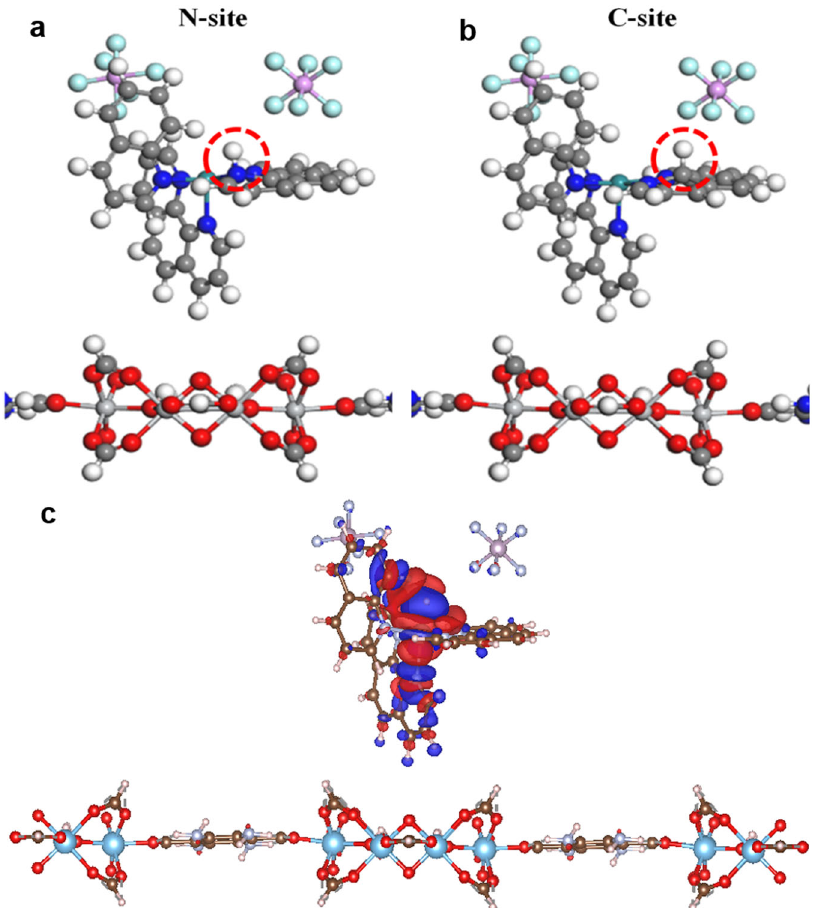
Fig. 6 DFT studies and their consecutive models. DFT-Optimized ball and stick structures of hydrogen adsorption on a N-site, b C-site of polymer. We have only shown the structure around the polymer, c difference charge density of PPDAR@Ti-MOF with the adsorption of hydrogen, where the iso-surface value is set to be 0.0006 e Å − 3 , and the positive and negative charges are shown in red and